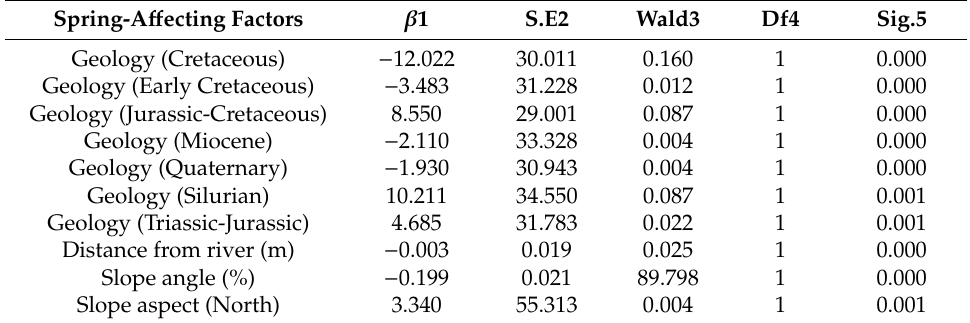
Table 3. Coe ffi cients of each spring-a ff ecting factors used in logistic regression (LR) Table 3. Coef fi cients of each spring-affecting factors used in logistic regression (LR) model.